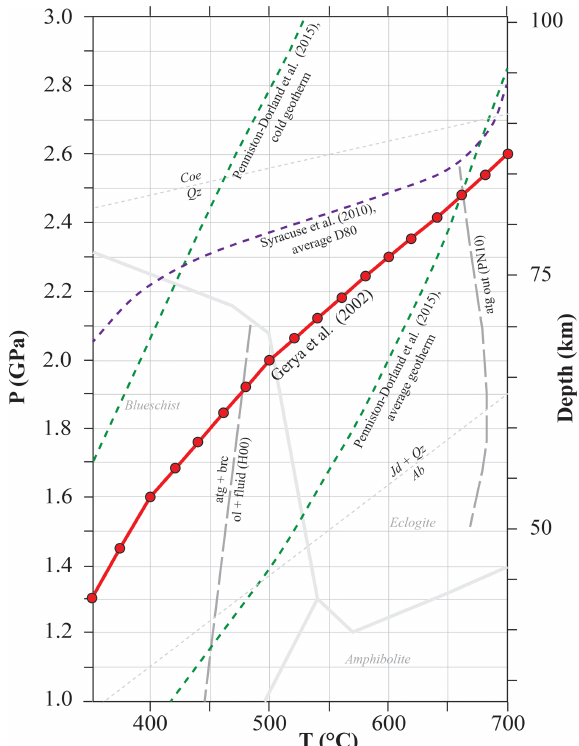
Figure 2. P – T diagram showing typical oceanic subduction geotherms and the intermediate geotherm used in the calculation (red line, Gerya et al., 2002). The red spots represent the modelling steps. The average D80 geotherm from Syracuse et al. (2010) (pur- ple dashed line), i.e. the geotherm dominated by a steep T gradi- ent at 80km depth, which occurs at the transition from partial to full coupling, as reported by Penniston-Dorland et al. (2015) and the average slab-top geotherm from Penniston-Dorland et al. (2015) (green dashed lines) are shown for comparison. Metamorphic facies modified from Peacock (1993) and Liou et al. (2004). Serpentine breakdown reactions from Padrón-Navarta et al. (2010) (PN10) and Hermann et al. (2000) (H00). Mineral abbreviations from Whitney and Evans